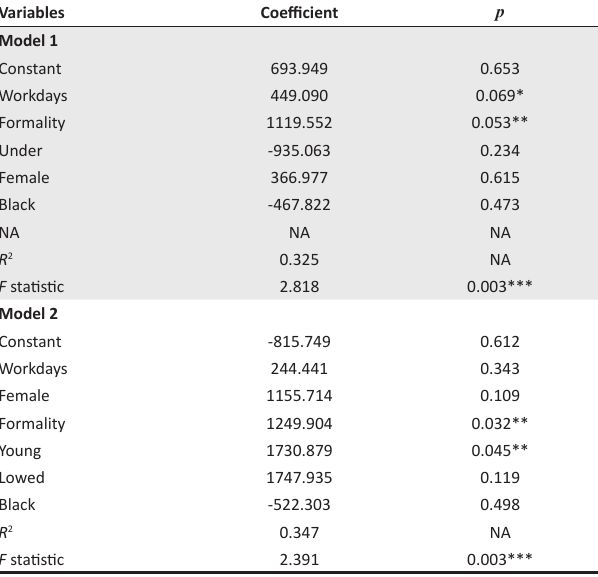
TABLE 1-A1: Income models including race and gender.